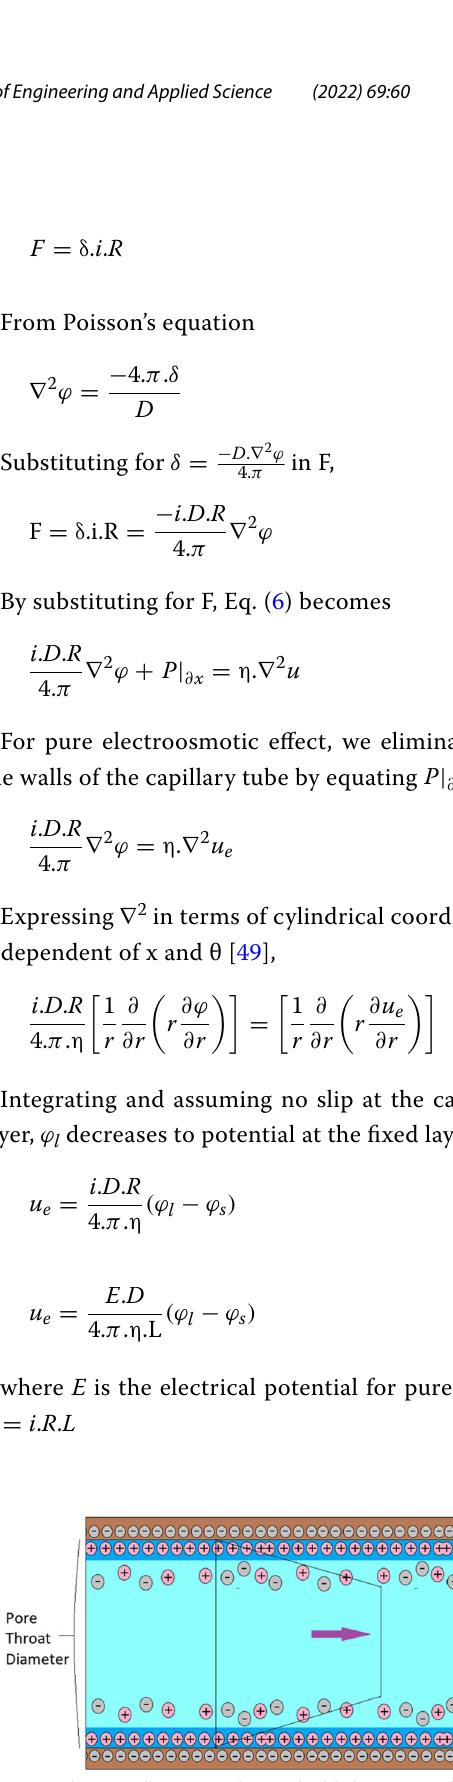
Fig. 4 Schematic illustrating electric double layer principle using capillary